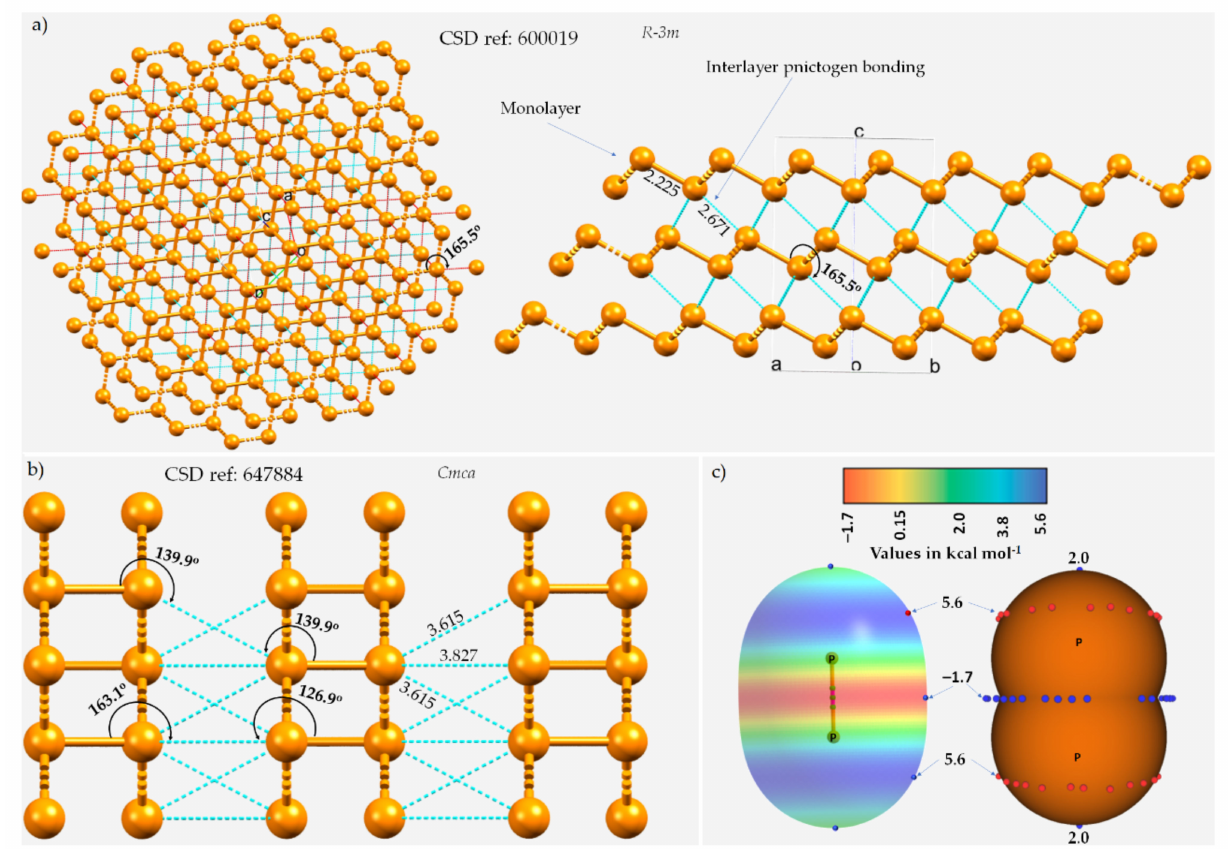
Figure 1. The ball-and-stick mode of the structure of ( a ) A7 rhombohedral 0.19(P 31 ) n crystal of phosphorus and ( b ) orthorhombic black phosphorus, showing interlayer P ··· P type pnictogen bonded interactions. ICSD references and space groups for each are shown. Selected bond lengths and bond angles are in Å and degrees, respectively. ( c ) The MP2(full)/aug-cc-pVTZ level 0.001 a.u. isodensity envelope mapped electrostatic potential surface of an isolated P 2 molecule. The tiny red and blue circles in ( c ) represent the local maxima and local minima of electrostatic potential ( V S,max and V S,min , respectively). Dotted lines in cyan represent an interaction between a pair of P atoms, and those in red, as in ( a ), represent hanging contacts. The quantum theory of atoms in molecules (QTAIM)-based molecular graphs are superimposed in ( c ), and the bond paths are in atom color, accompanied by bond critical points (tiny sphere in green). The phosphorus atoms in ( a , b ) are colored